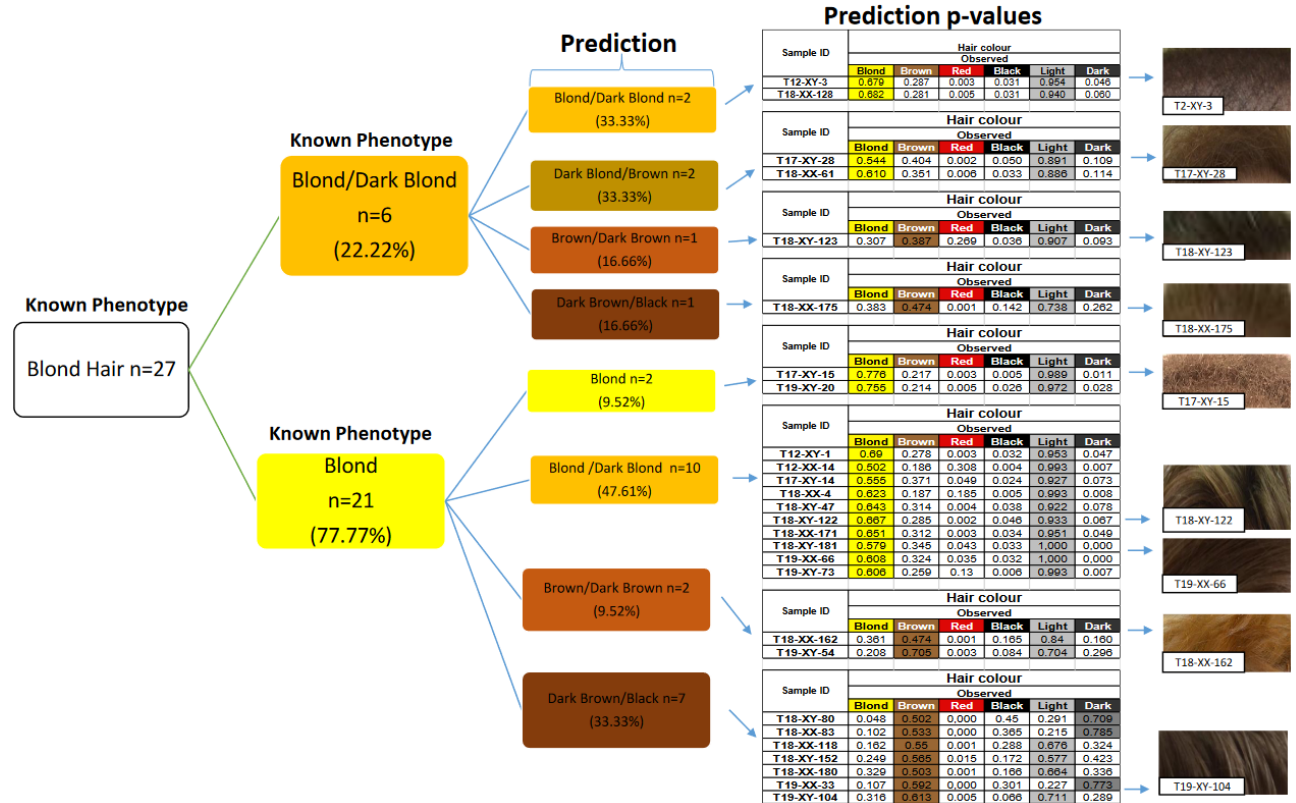
Figure 2. Distribution of the blond hair colored individuals (N = 27) and their prediction results. The HIrisPlex model yields additional hair color shade prediction values (light and dark) to aid in the better classification of each hair color. The p -value of the light color shade provides additional information for blond hair color predictions [16,29].